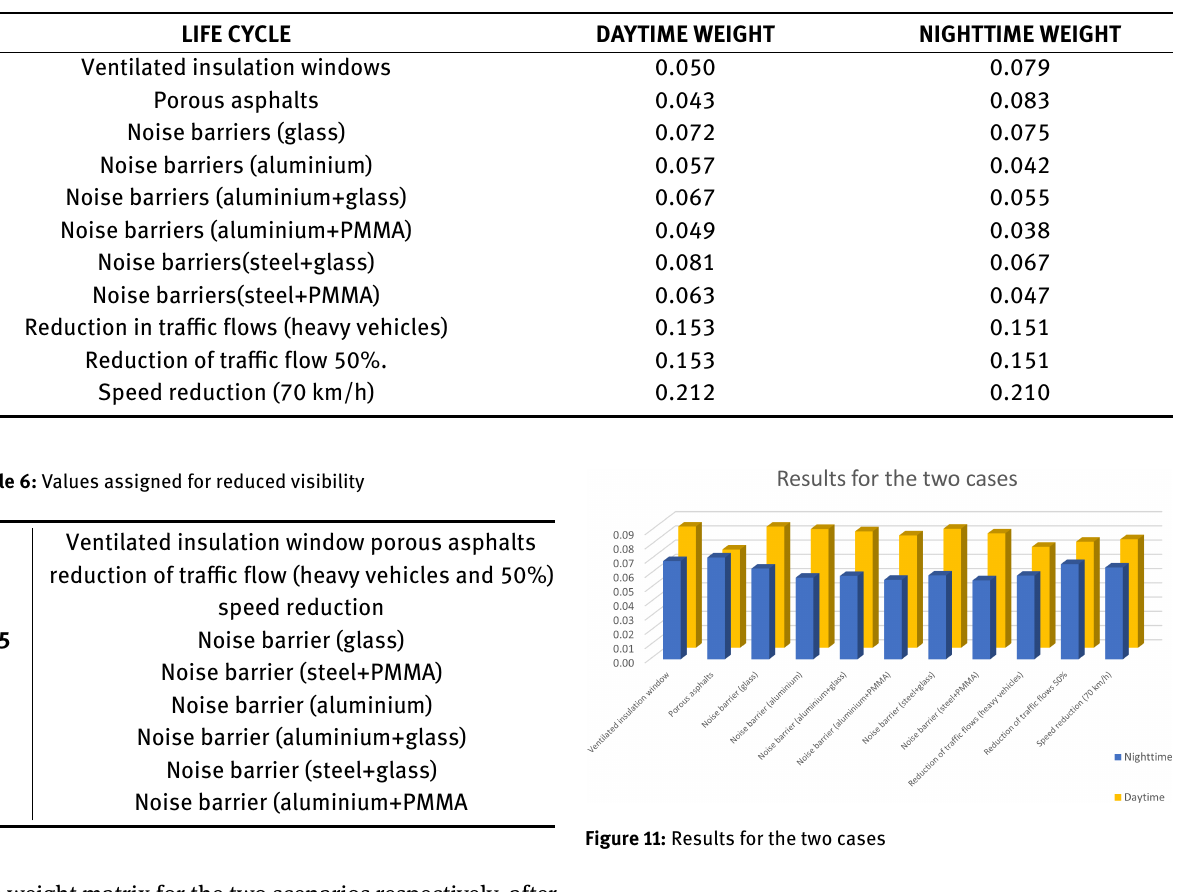
Table 5: Weight matrix for life cycle, day and night scenario